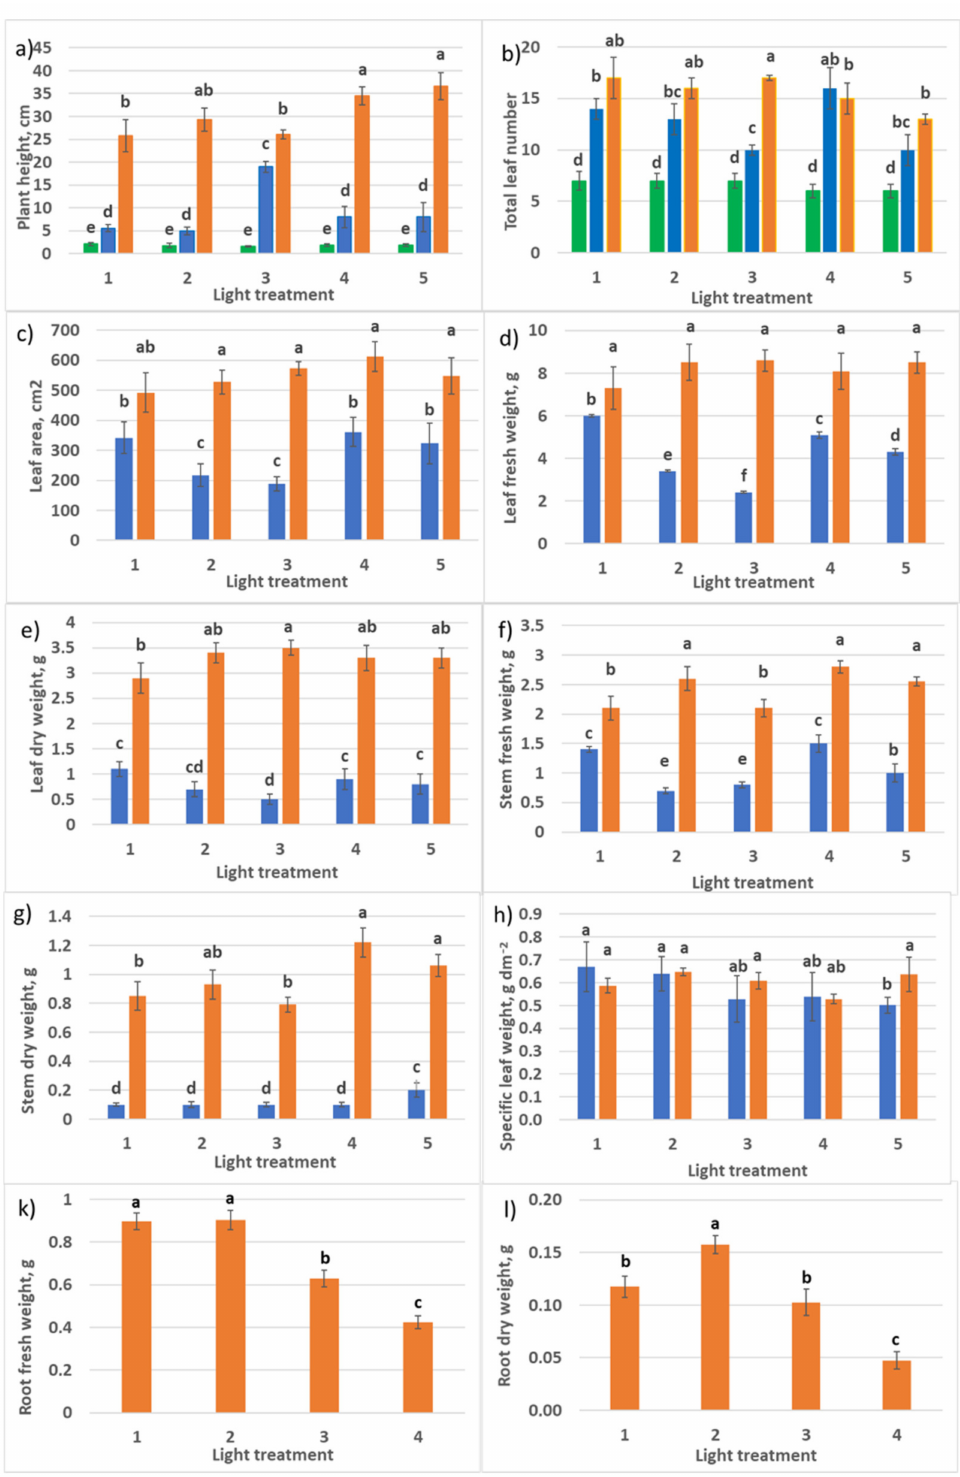
Figure 10. Growth parameters of raspberry plants as affected by different red (R)–green (G)–blue (B) light ratio. Sampling 1 day (green columns), 30 days (blue columns), and 60 days (orange columns) after transplanting. Means ± standard error (SE); means followed by the same letter were not different at p ≤ 0.05. ( a ) Plant height; ( b ) total leaf number per plant; ( c ) total leaf area; ( d ) total leaf fresh weight; ( e ) total leaf dry weight; ( f ) stem fresh weight; ( g ) stem dry weight; ( h ) specific leaf weight; ( k ) root fresh weight; ( l ) root dry weight. Treatment 1—50% R, 25% G, 25% B; Treatment 2—37% R, 26% G, 37% B; Treatment 3—24% R, 28% G, 48% B; Treatment 4—63% R, 16% G, 21% B; Treatment 5—46% R, 30% G, 23%